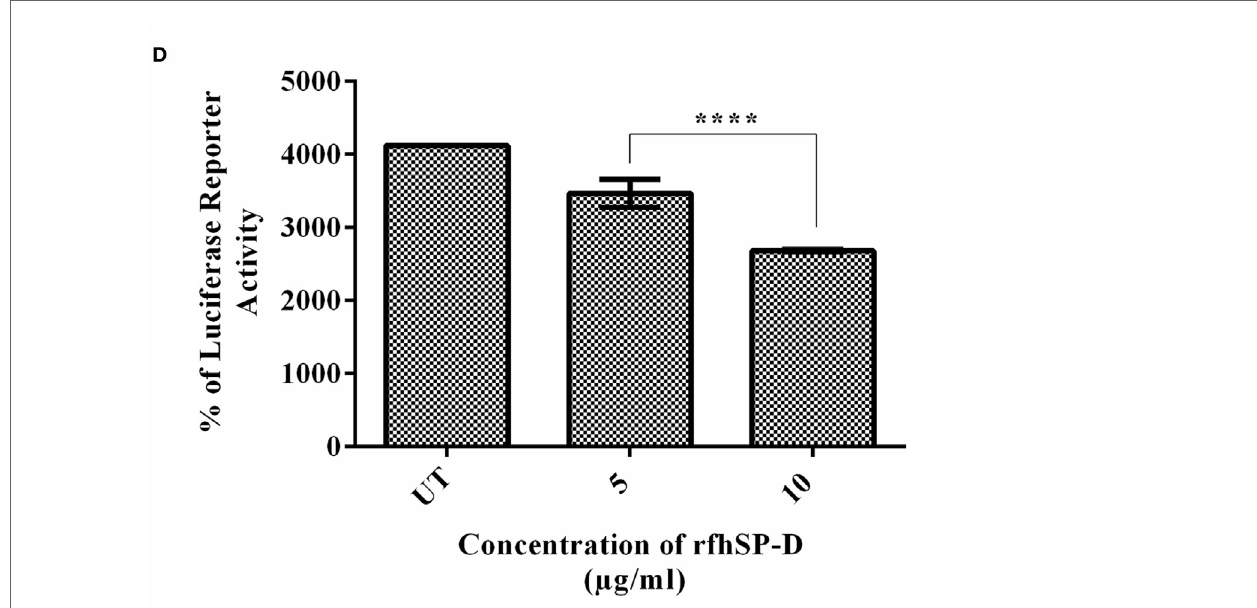
FigUre 8 | (a) Western blotting to show the expression of influenza A virus-hemagglutinin (HA) protein in purified H1 + N1 pseudotyped lentiviral particles and cell lysate at 24 and 48 h. The presence of HA was identified at 70 kDa. (B) Far western blotting to show rfhSP-D binding in both purified H1 + N1 pseudotyped lentiviral particles and cell lysate at 24 and 48 h. HA was evident at 70 kDa when probed with rfhSP-D. (c) Luciferase reporter activity of purified H1 + N1 pseudotyped lentiviral particles at 24 and 48 h, and (D) Luciferase reporter activity of rfhSP-D treated MDCK cells transduced with these lentiviral particles. Significance was determined using the unpaired one-way ANOVA test (* p < 0.05 and **** p < 0.0001) ( n =